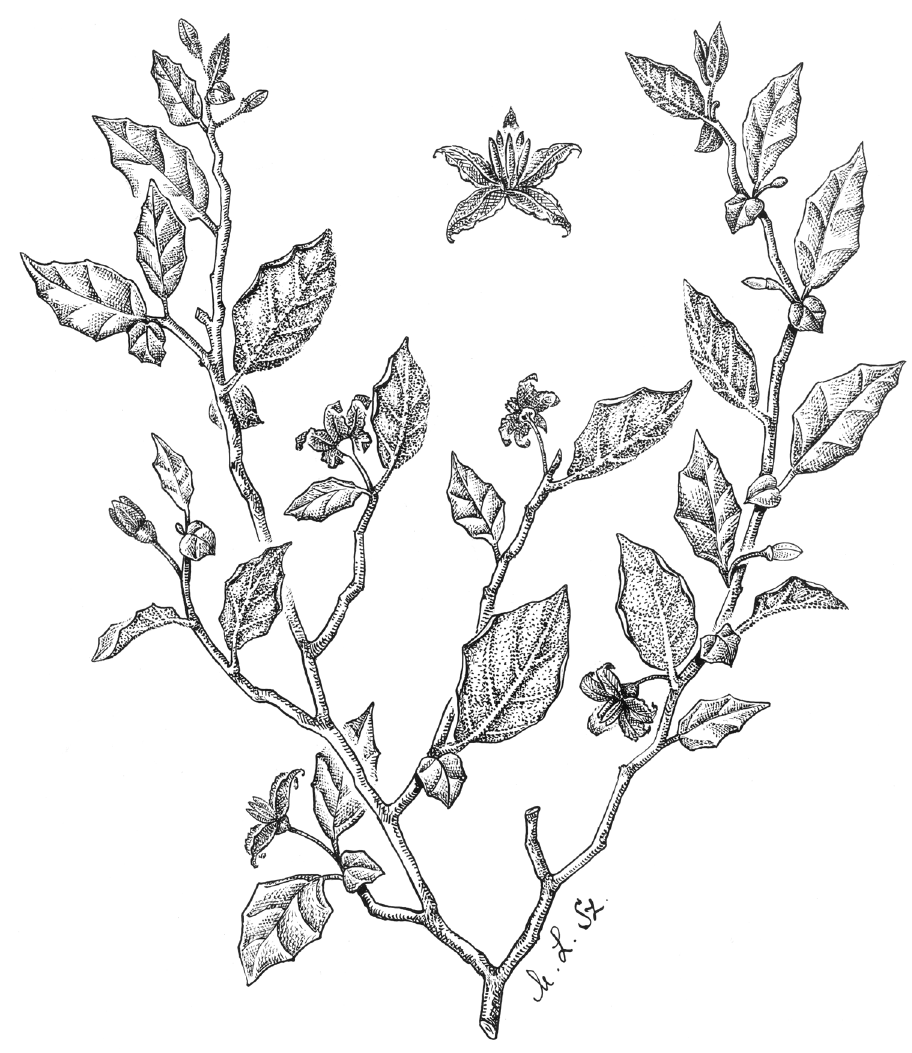
Figure 19. Lycianthes dendropilosa (Symon) A.R.Bean. Drawing by M.L. Szent-Ivany, first published in Symon (1985: fig. 11, as S. dendropilosum Symon). Courtesy of the Board of the Botanic Gardens and State Herbarium (Adelaide, South Australia), reproduced with